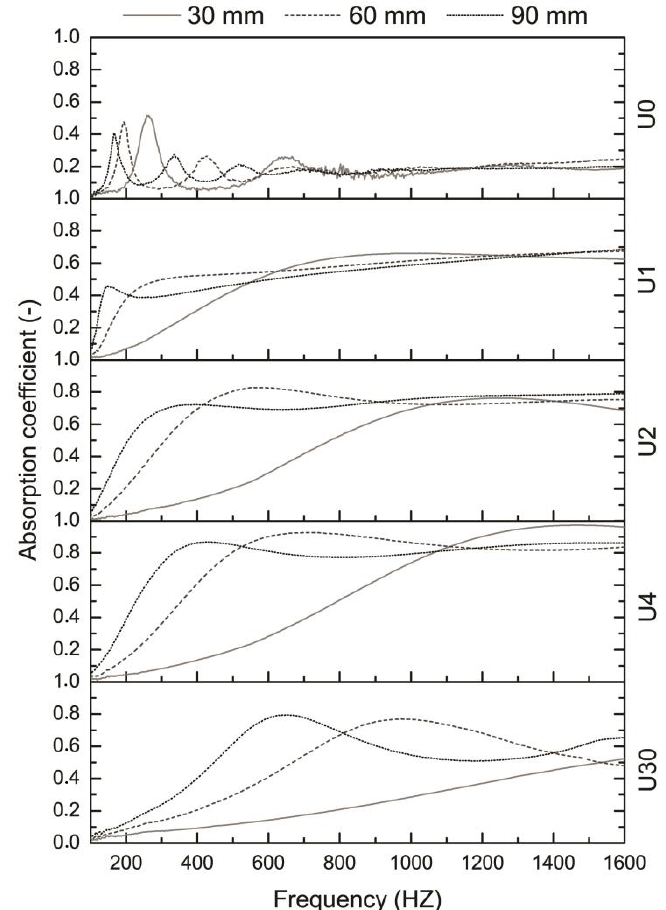
Figure 12. Absorption coefficient of the unbound samples.